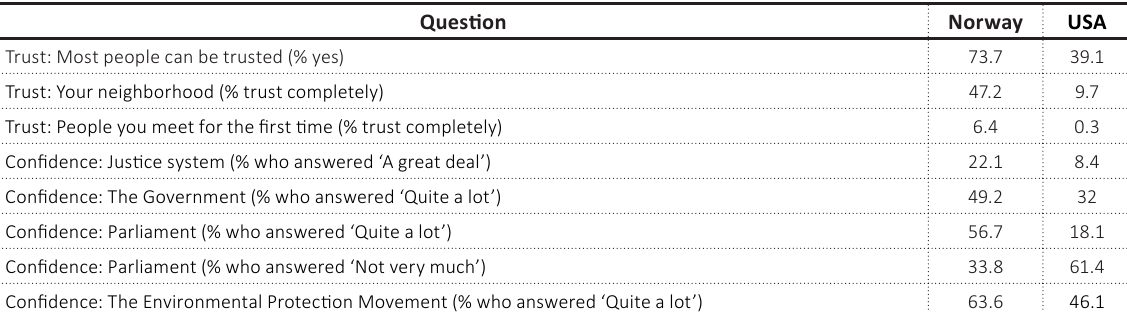
Source: World Value Survey (2014), Data accessed June 29,